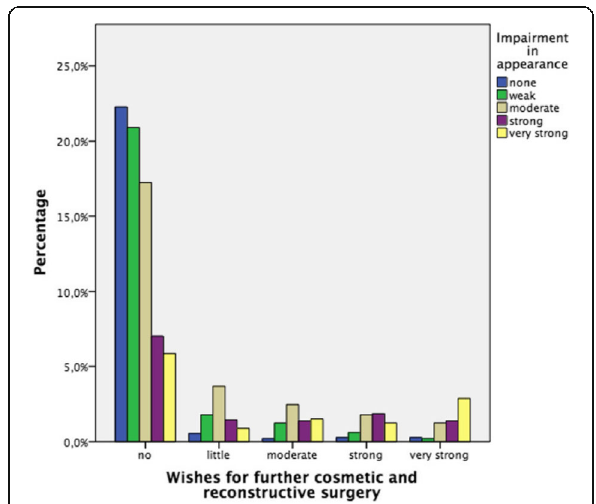
Fig. 1 Impairment of appearance grand wish for further